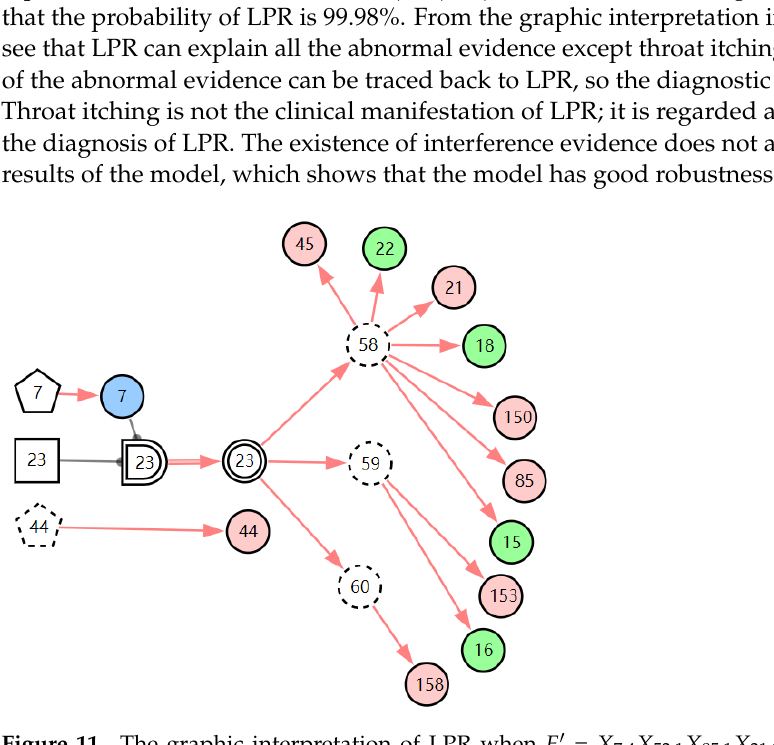
7,4 X 52,1 X 85,1 X 21,1 X 15,1 X 45,1 11 of 17